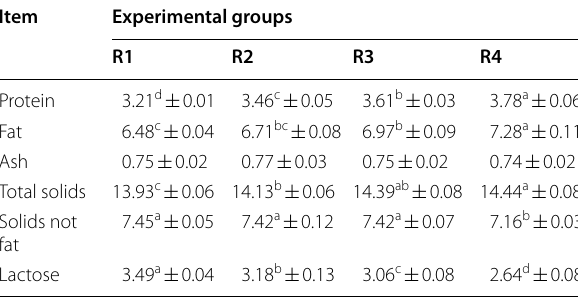
a,b,c,d Means within rows followed by different superscripts are significantly different at ( P < 0.05)